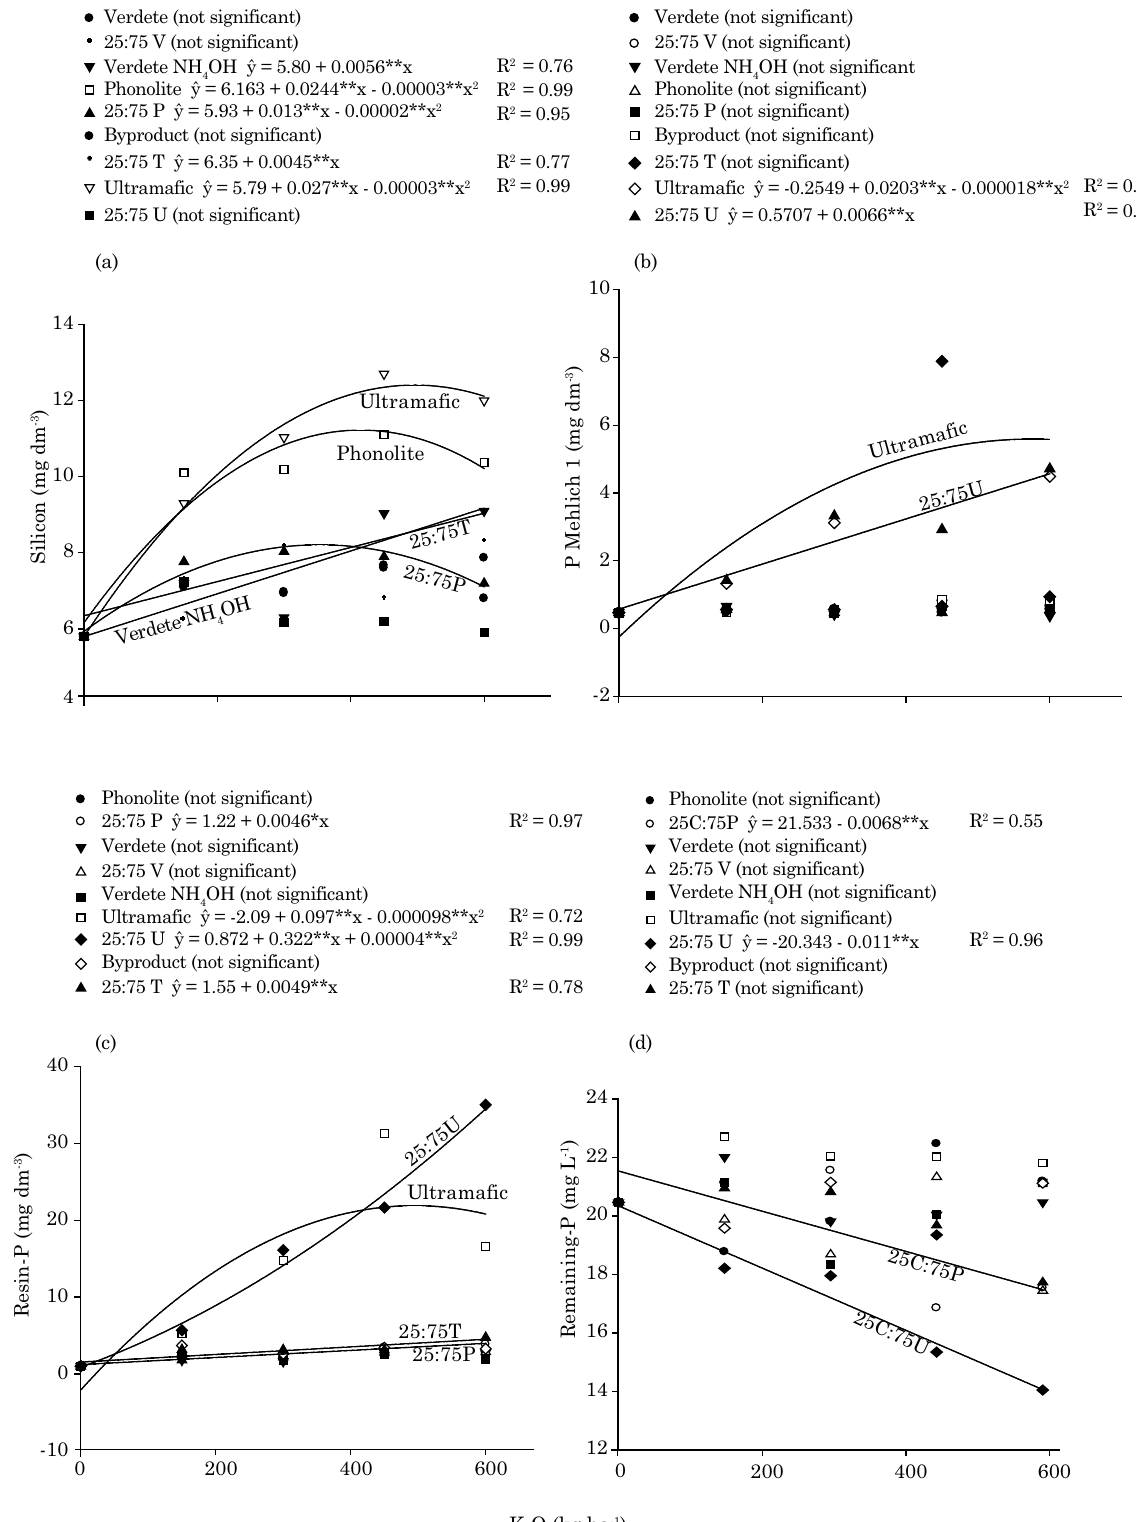
Figure 4. Content of: (a) silicon, and phosphorus in soil: (b) extractor Mehlich-1; (c) resin-P; and (d) remaining-P, according to treatments, after a 45-day incubation. * significant at 5 % by the Scott Knott